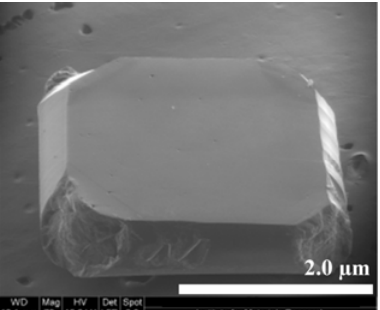
Figure 2. SEM image of a 600 µm thick freestanding homo-epitaxial SCD film grown at a /H ratio removed from the substrate by laser cutting (IMEC, Belgium, Wide 10% CH 4 2 Band Gap Materials) .